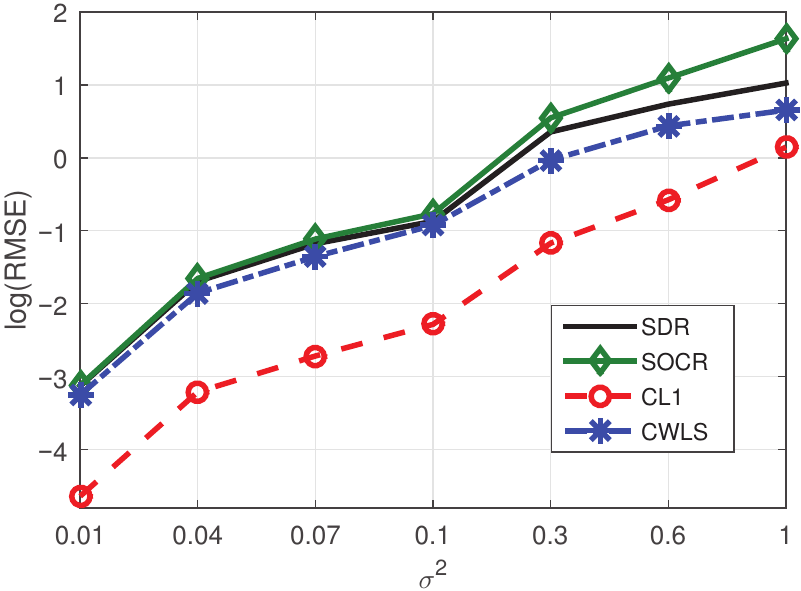
Figure 5. RMSE comparison of four methods under the conditions of eight BSs and one